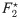
FRET efficiency and interacting fraction estimation at low photon counts.The uncertainty, as measured by the standard deviation of the estimated parameter distribution, in the bi-exponential decay parameter estimates obtained using ML, LS, and Bayesian analysis for the analysis of synthetic data simulating a bi-exponential decay. In (a) and (d) are the fractional errors in FRET efficiency and interacting fraction respectively versus photon count, in (b) and (e) the same for different FRET efficiencies E⋆, and in (c) and (f) for different interacting fractions F2⋆. In all cases, the normalised width is displayed only when the respective estimates are not biased by more than 5% of the true value. See main text for details.